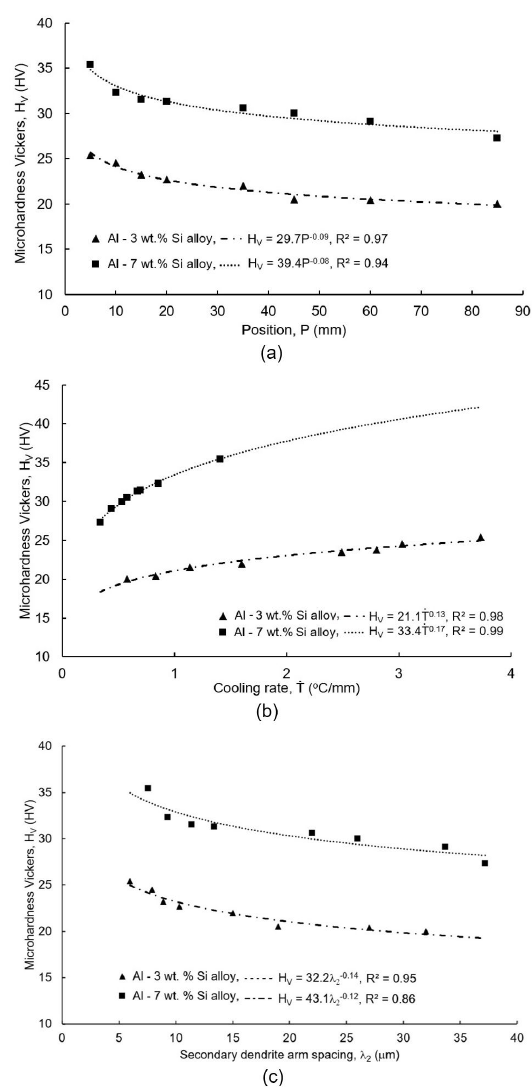
Figure 12. Microhardness Vickers versus: a) Position ( P ) along  the castings, b) Cooling rate ( ) T , and c) Secondary dendrite arm spacing (λ 2 ) versus: a) position 2